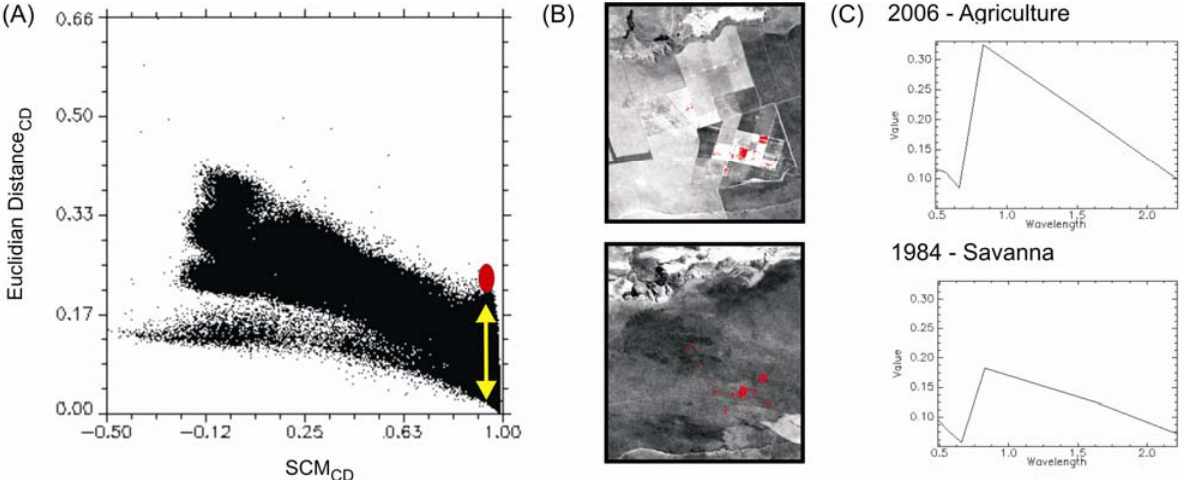
Figure 9. ( a) Spectral Correlation Mapper for change detection (SCM distance scatterplot showing a data point having a high SCM value and low Euclidian distance (red spot); (b) 1984 and 2006 images with points having the (SCM distance) tagged as the red spot in (a); and (c) their average